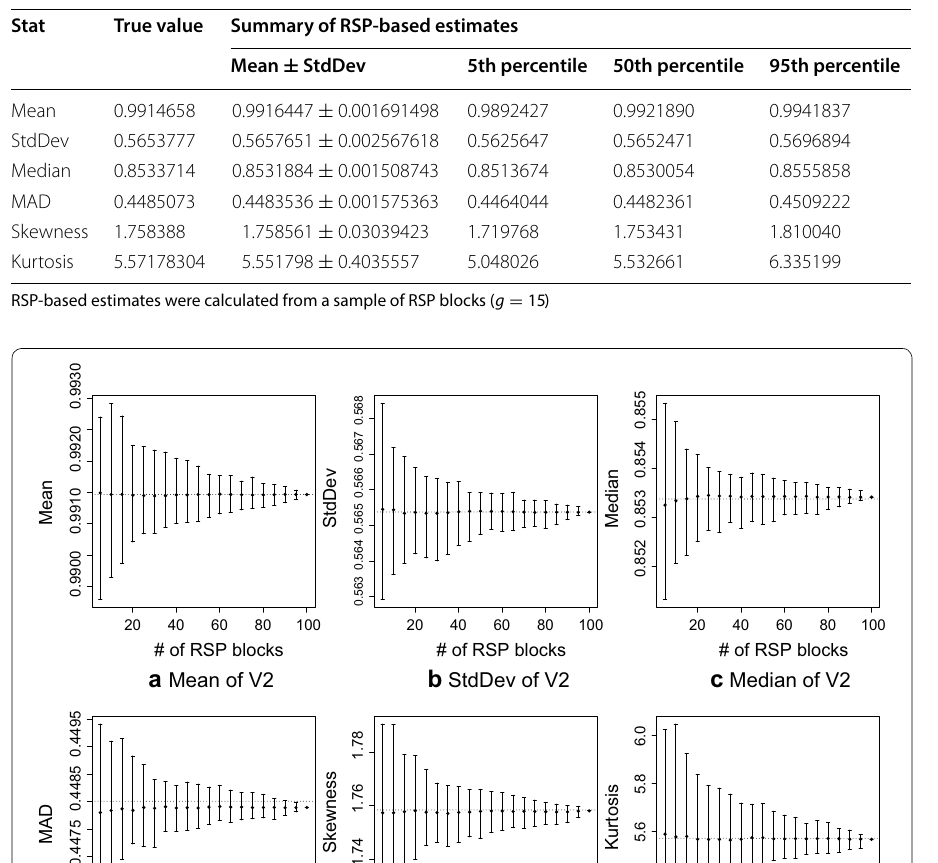
Table 2 Summary statistics of V2 in HIGGS data